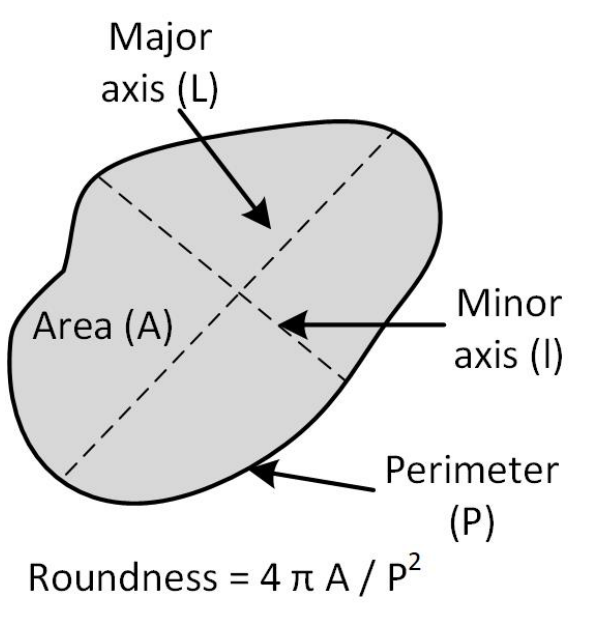
Figure 3. Morphological features in the segmented microstructural element.